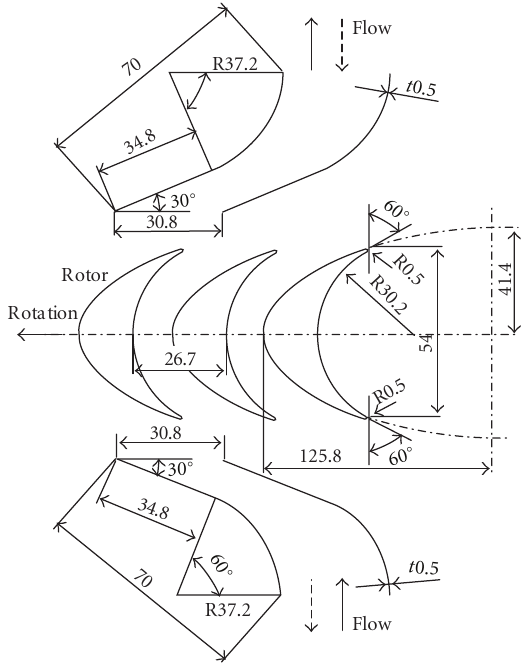
Figure 9: Impulse turbine with fixed guide vanes (IFGV).